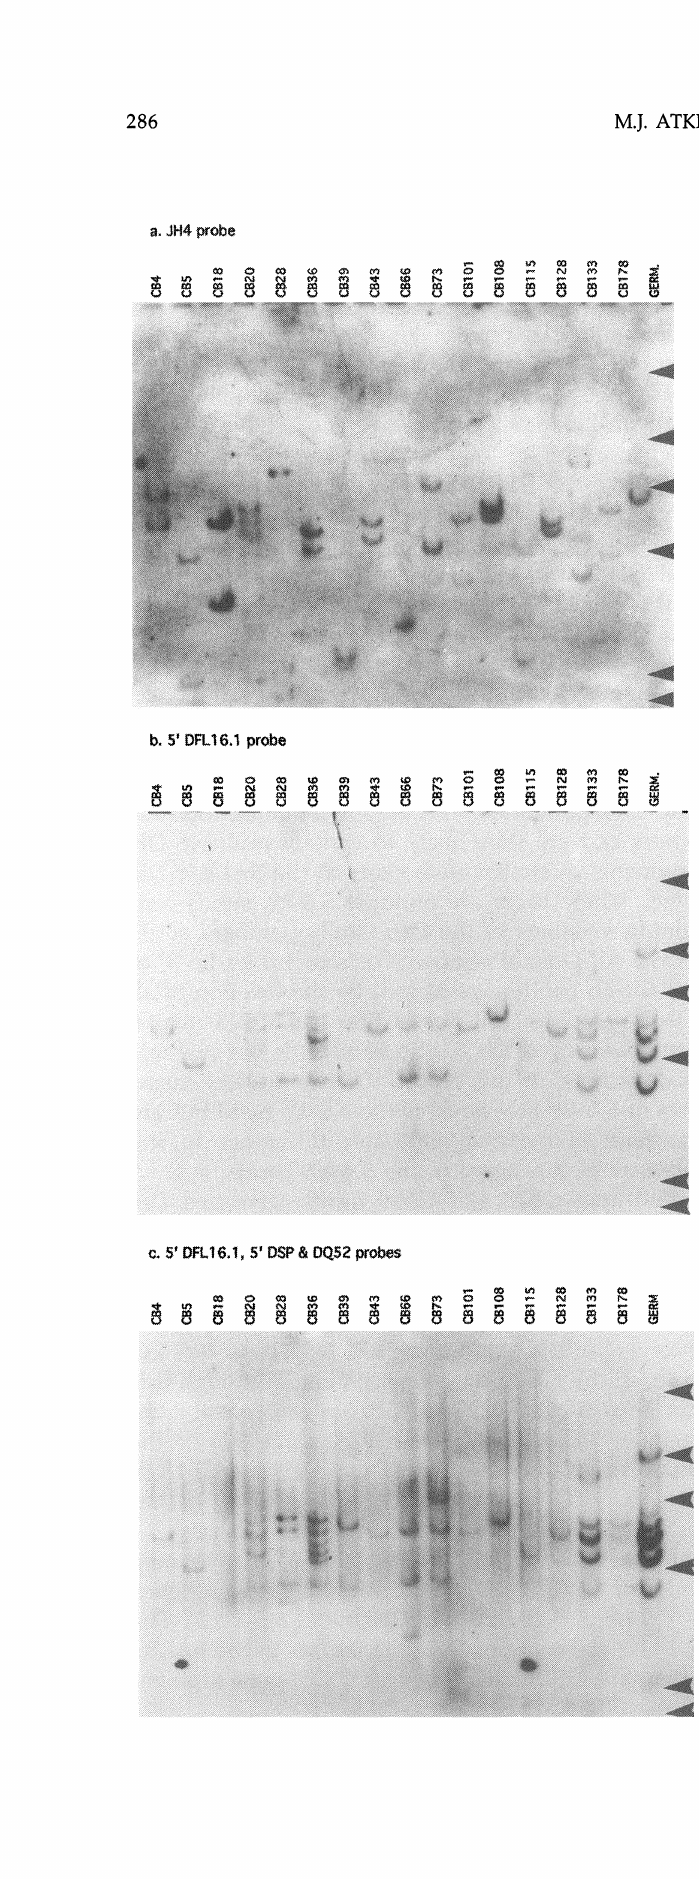
FIGURE 4. Southern analysis of Igh b D-JH rearrangements in (C57BL/6XBALB/c) cell lines: Filters containing DNA from cell lines C57BL/6 kidney DNA (GERM) was hybridized with (a) JH4; (b) 5’ DFL16.1; and (c) a combination of 5’ DFL16.1, 5’ DSP, and DQ52 probes. Cell lines in this study were determined to have a VHDJH rearrangement on the Igh allele and a D-JH rearrangement on the Igh b allele. Cell lines with two major JH hybridizing bands were selected for DH locus-deletion analysis. Relative map order of DH hybridizing bands was determined by comparing bands deleted by rearrangement to germline bands. The filter was stripped and exposed between each probing to ensure complete stripping. The size markers are indicated by arrows at the side of the blots and are shown top to bottom as 23.1, 9.4, 6.6, 4.4, 2.3, and